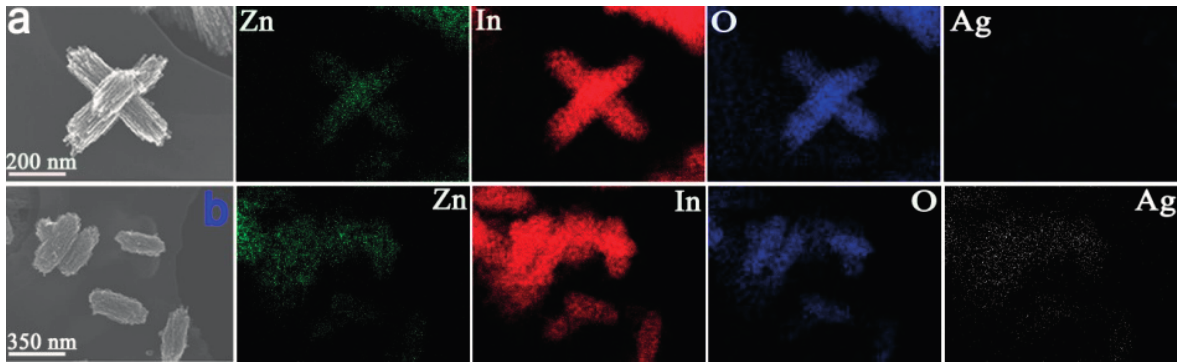
Figure 1. ( a – c ) Low- and high-magnification SEM images of Z 1, In 2 O 3 /ZnO bundles, the inset in (a) is the EDX pattern, and the image ( c ) is a close-up of the marked place in ( b ). ( d – f ) Low- and high-magnification SEM images of Z 2, Ag-modified In 2 O 3 /ZnO bundles, the inset in ( c ) is the EDX pattern, and the image ( f ) is a close-up of the marked place in ( e ).